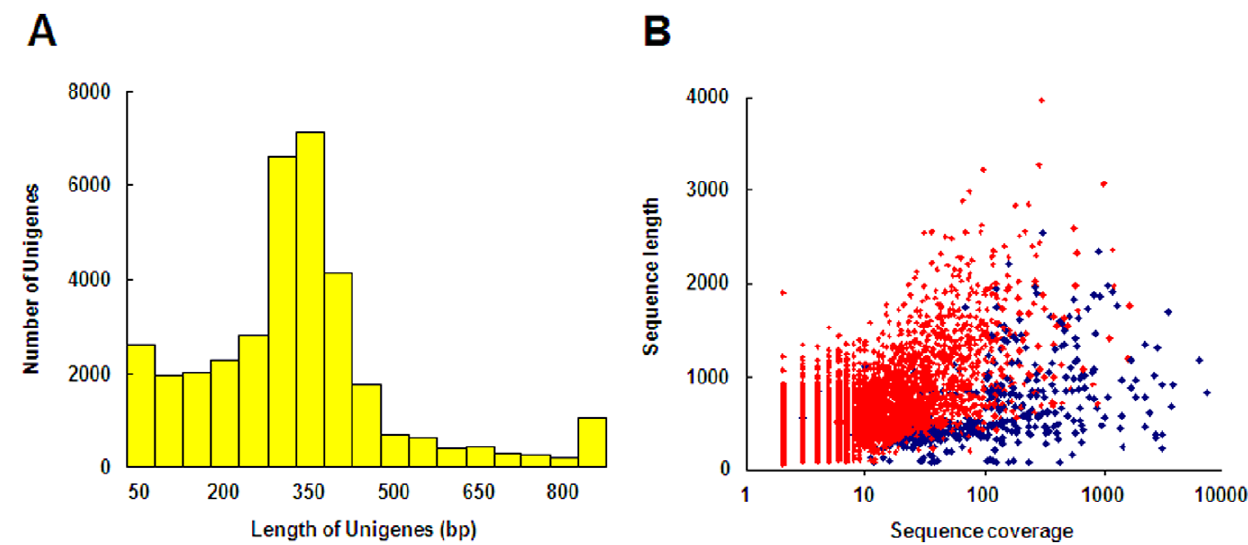
Figure 2. Overview of H.diversicolor transcriptome sequencing and assembly. (A) Size distribution of the unigenes. (B) Coverage of the assembled sequences with length distributions. The red plots represent those assembled sequences without Bsg I restriction sites at their 5’ or 3’ ends, and the blue plots represent those assembled sequences with Bsg I restriction sites at their 5’ or 3’ ends, which explains the short contigs/scaffolds with high coverages.